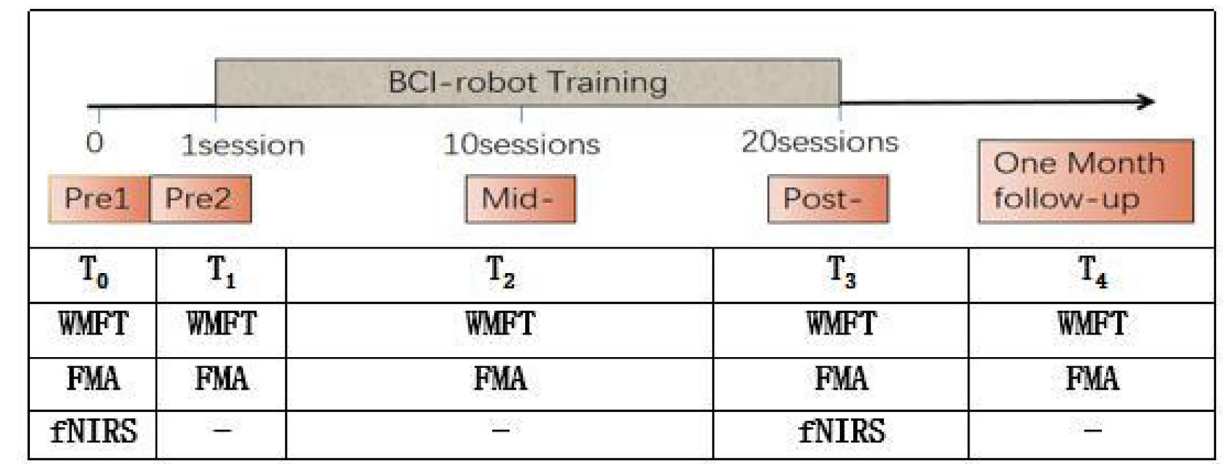
FIGURE 1 | Timing of assessments.